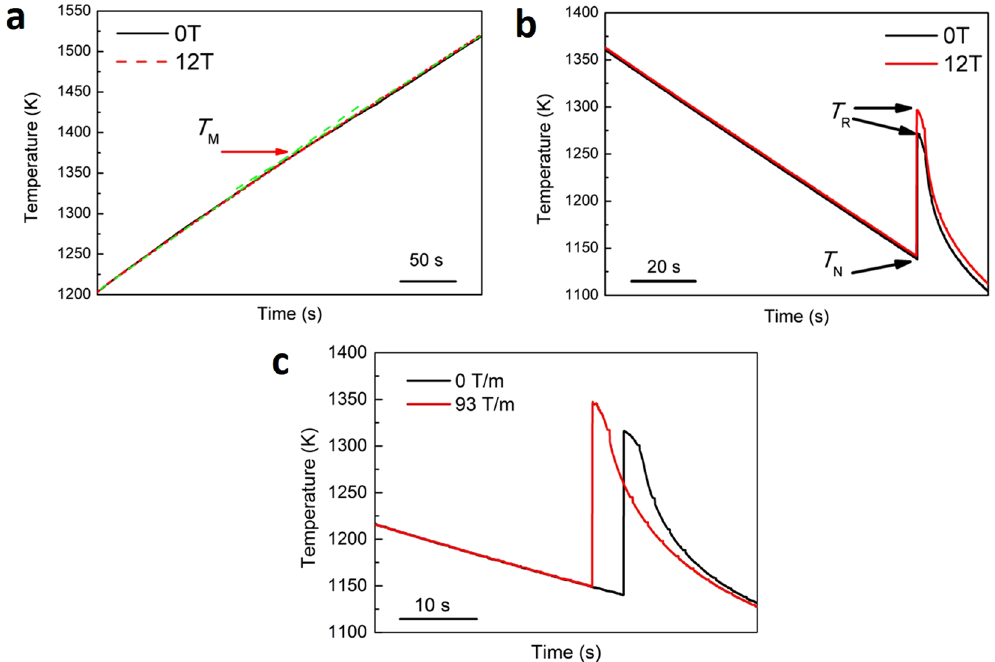
Figure 2. Typical temperature-time curve of Co 76 Sn 24 near eutectic alloy measured in and without magnetic field. ( a ) The heating curves showing the melting point, the cooling curves showing the recalescence event, ( b ) in homogeneous magnetic field and ( c ) in gradient magnetic field. The melting point is not so evident but can be determined from the slope variations. The application of magnetic field has very limited effect on the melting T M during heating and nucleation T N during cooling process since the red and black curves are almost overlapped, but we can see difference of the maximum temperature T R during recalescence